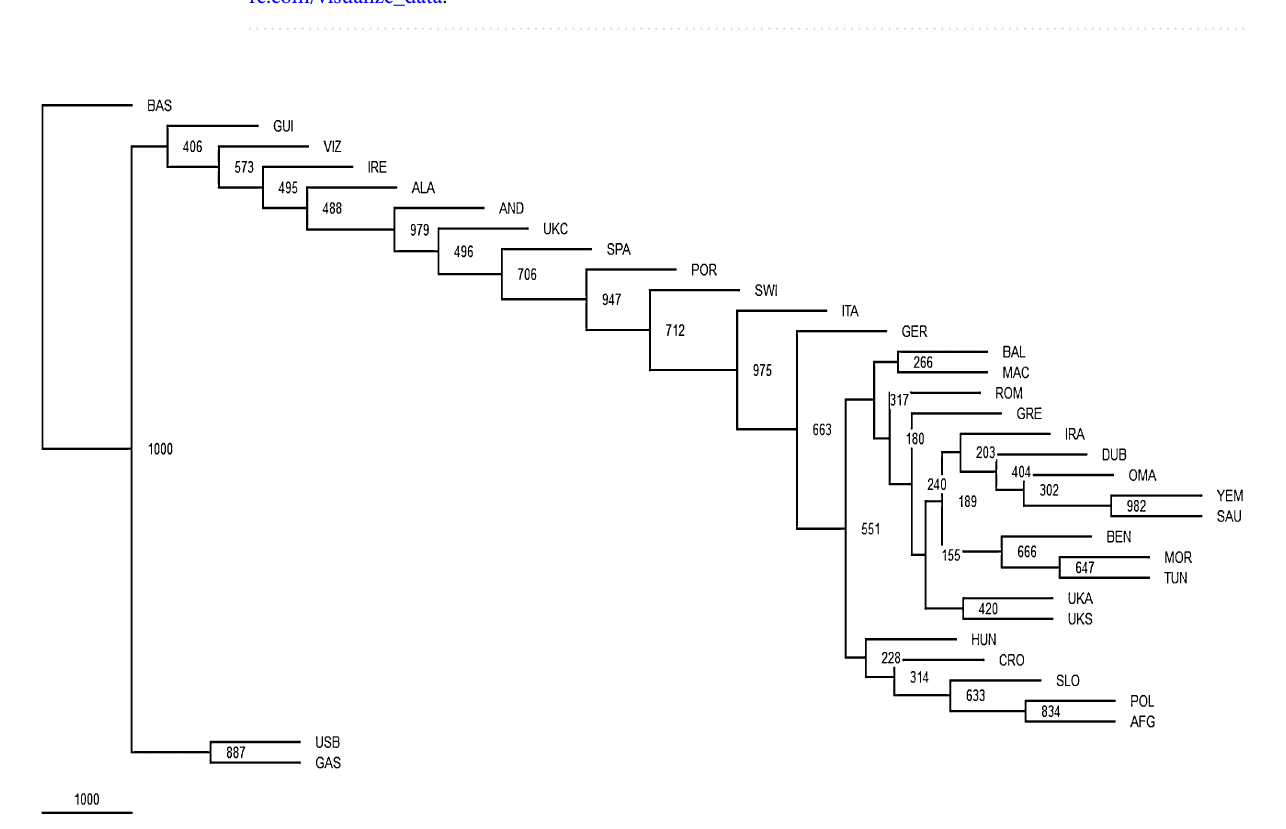
Figure 2. MDS plot based on Rst distances. Stress value = 0.1383, R 2 = 0.92444. SPSS v14.0 at http://www.qluco re.com/visua lize_data.